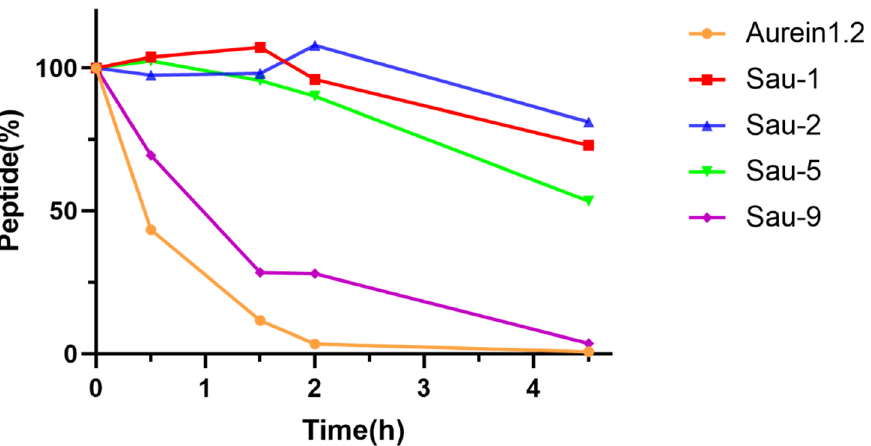
Figure 4. Proteolytic stability of Aurein1.2, Sau-1, Sau-2, Sau-5, and Sau-9. They were dissolved in chymotrypsin solution (10 ng/ μ L, 50 mM, containing 2 mM of CaCl 2 , pH = 7.4). The percentages of the remaining peptides were monitored by HPLC.